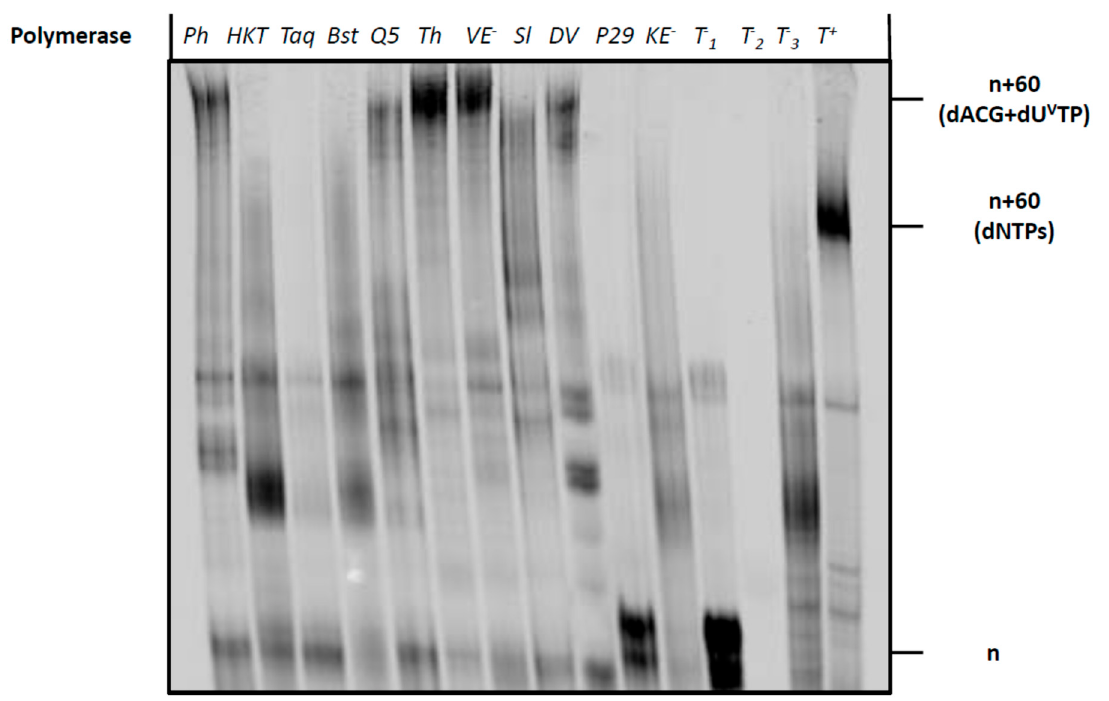
Figure 5. Gel analysis (PAGE 20%) of PEX reaction products carried out with the Phusion (Ph) (2U), Hemo Klem Taq ( HKT ) (8U), Taq (5U), Bst (8U), Q5 (2U), Therminator (Th) (2U), Vent (exo − ) (VE − ) (2U), Dpo4 (Sl) (2U), Deep Vent (DV) (2U), Phi29 (P29) (10U) and Kf (exo − ) ( KE − ) (5U) DNA polymerases with primer P2 and template T2 . Each reaction mixture contained T2 (15 pmol), P2 (10 pmol), dATP, dCTP, dGTP (200 µM), dU Van TP (200 µM), polymerase buffer (1 µL for 10X and 2 µL for 5X) and the respective polymerase and was incubated for 4 h at the appropriate temperature. The negative controls were performed without polymerase (T − 1 ), primer P2 (T − 2 ) and dU Van TP (T − 3 ). The positive control (T + ) contained dTTP instead of dU Van TP. n corresponds to unreacted primer P2 , n+60 (dNTPs) corresponds to the expected full-length product in presence of dNTPs and n+60 (dATP, dCTP, dGTP + dU Van TP) corresponds to the expected full-length product in presence of dU Van TP instead of